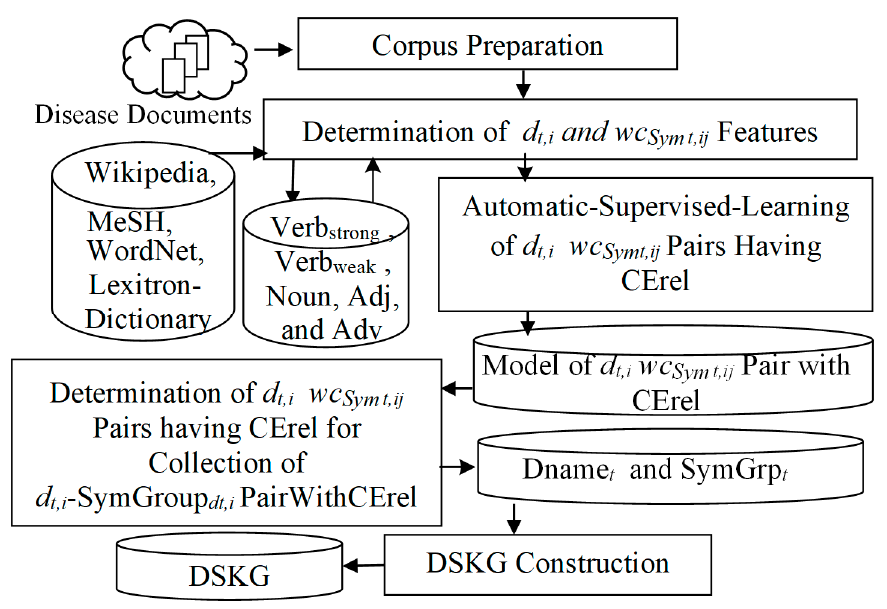
Figure 5. A Framework of DSKG